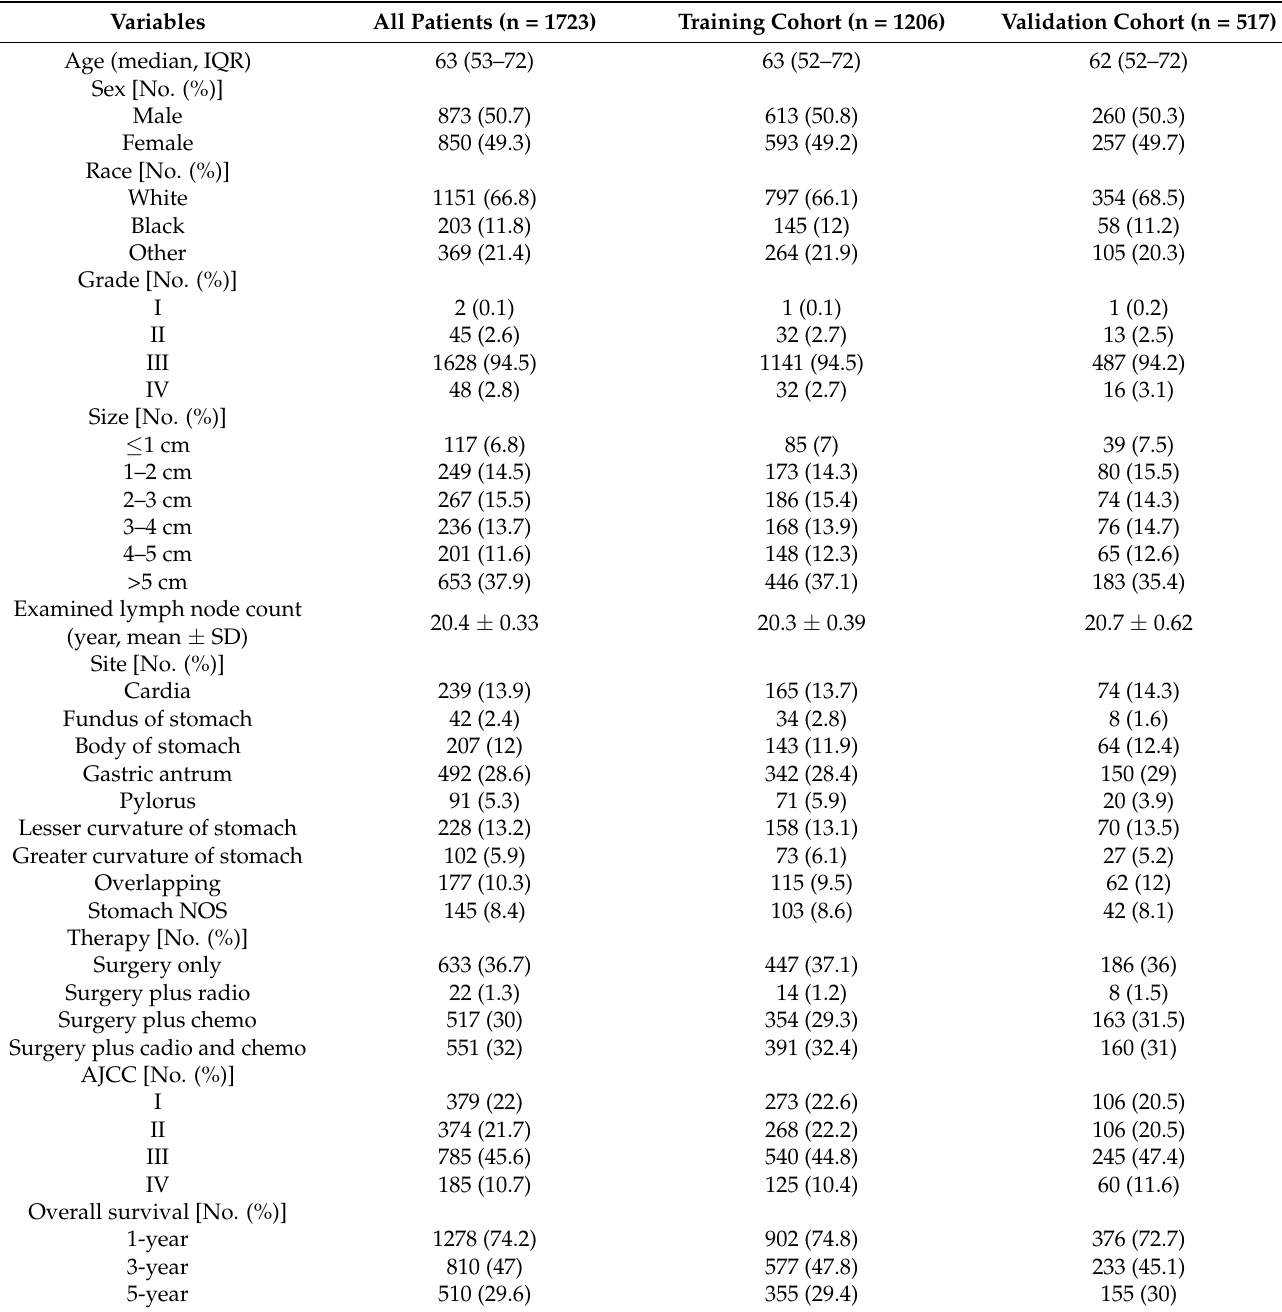
Table 1. Demographic and clinicopathological characteristics of